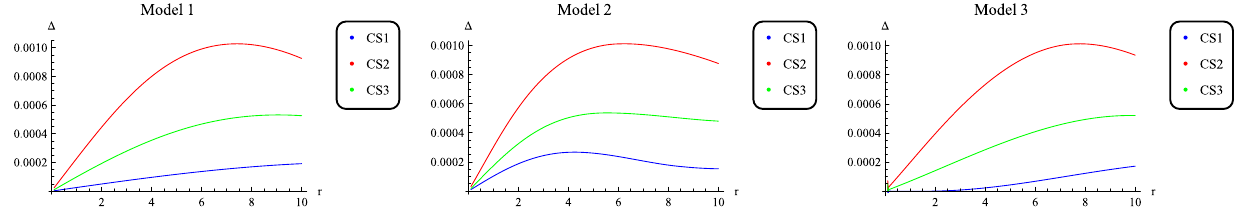
Fig. 13 Variations of anisotropicity, (cid:15) , with respect to